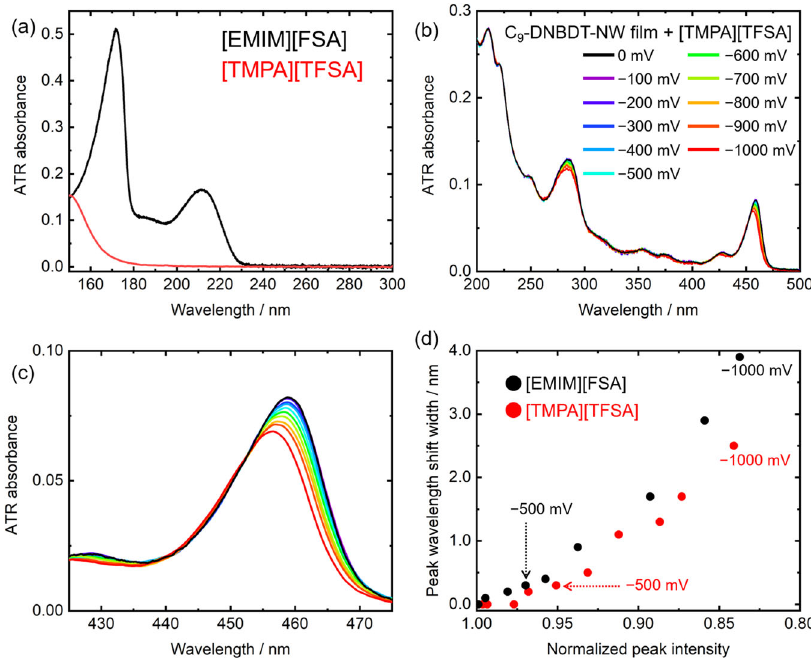
Fig. 5 Effects of IL species on the EC-ATR-UV spectra. a ATR spectra of [EMIM][FSA] and [TMPA][TFSA]. b ATR spectra of a C 9 -DNBDT-NW fi lm with